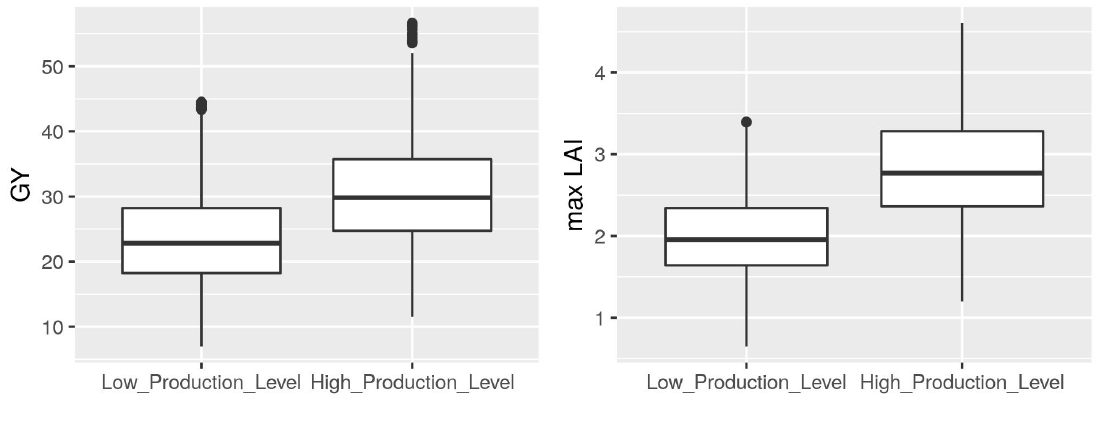
Figure 6. Grain yield (GY) and maximal LAI simulated during the Morris sensitivity analyses for the two contrasted production